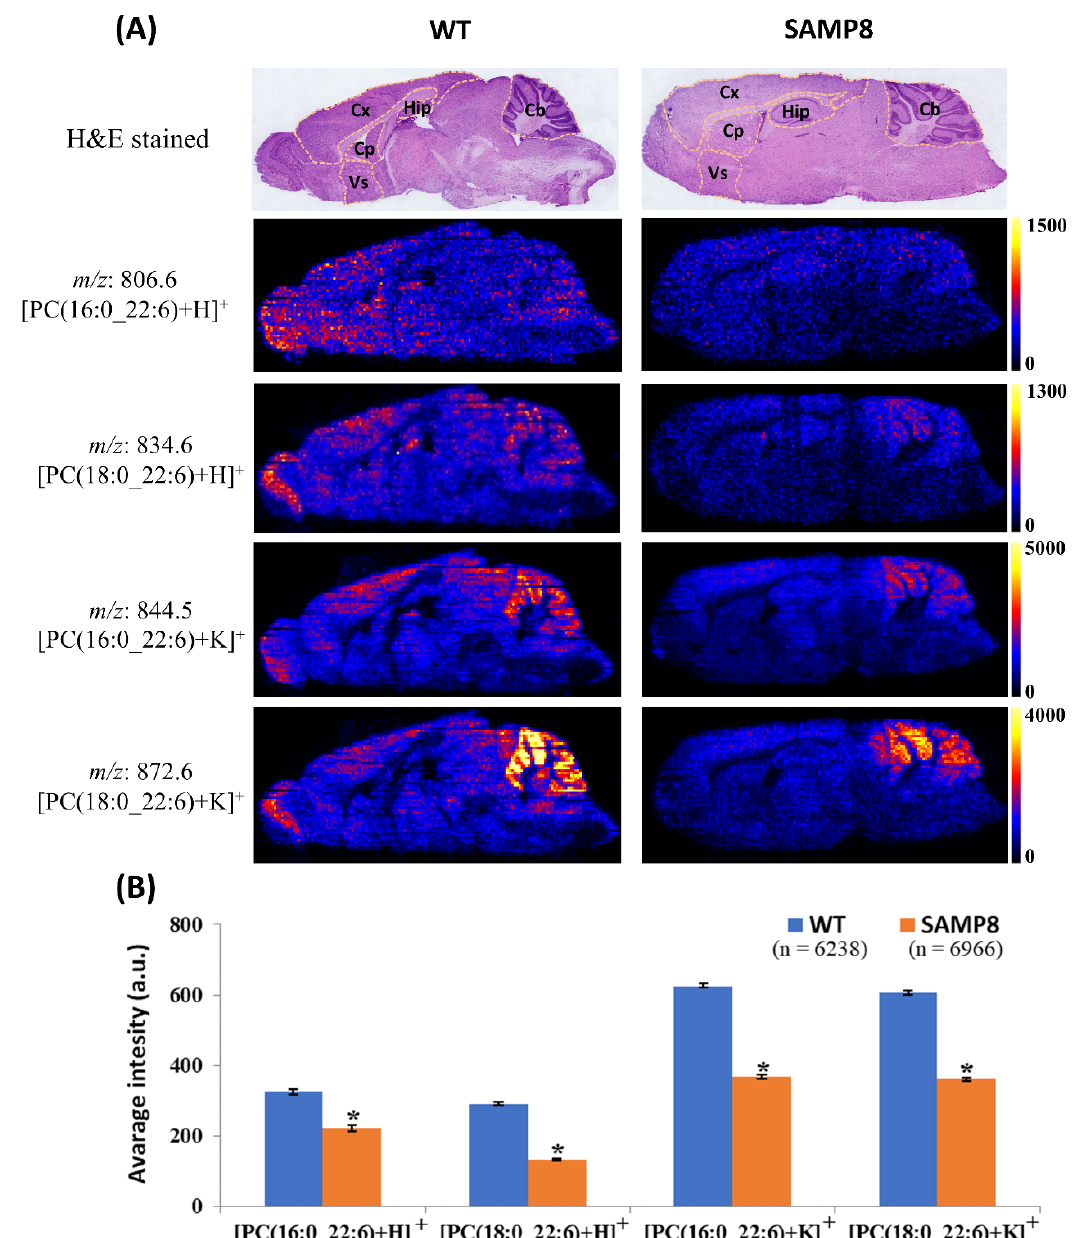
Figure 3. Di ff erences in the distribution levels of brain DHA-PCs between SAMP8 mice and WT mice. ( A ) Representative ion images of DHA-PCs in the brain of 14-week-old SAMP8 mice and 14-week-old WT mice. Here Cb, Cx, Hip, Cp, and Vs indicate cerebellum, cerebral cortex, hippocampus, caudate putamen, and ventral striatum, respectively. ( B ) Average intensity of DHA-PCs in whole sagittal section of 14-week-old WT and SAMP8 mice. All values are represented as mean ± SEM. Here ‘*’ indicates p < 0.05 (two-tailed t -test), ‘ n ’ indicates number of pixels, and ‘a.u.’ indicates arbitrary